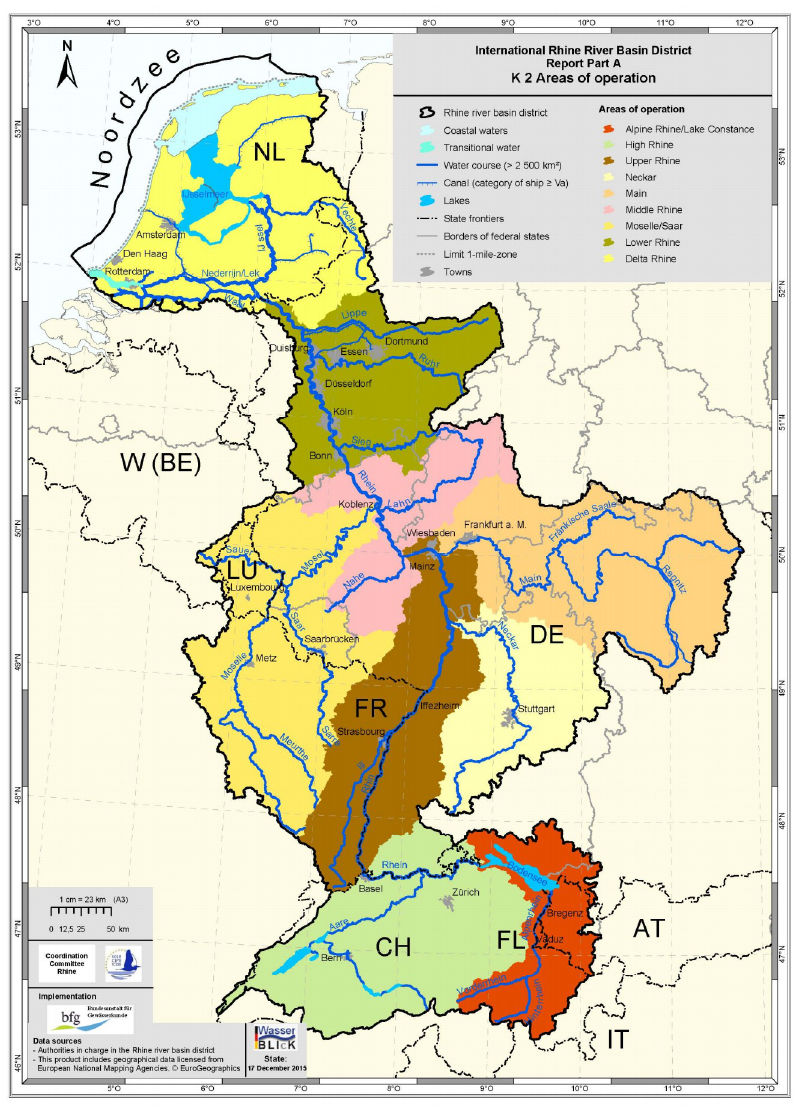
Figure 1. Rhine river basin [1].